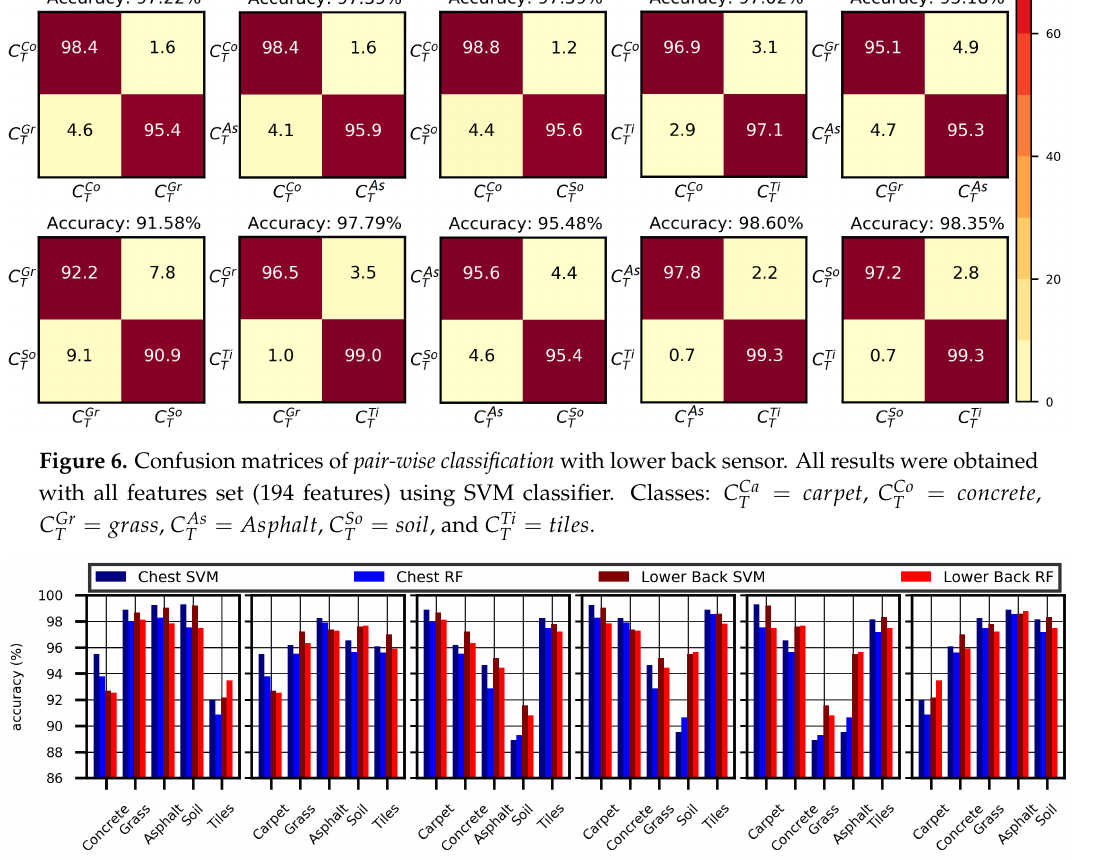
Figure 7. Bar chart of pair-wise classification. The results were obtained with all features set (194 features) for each classifier and for each sensor